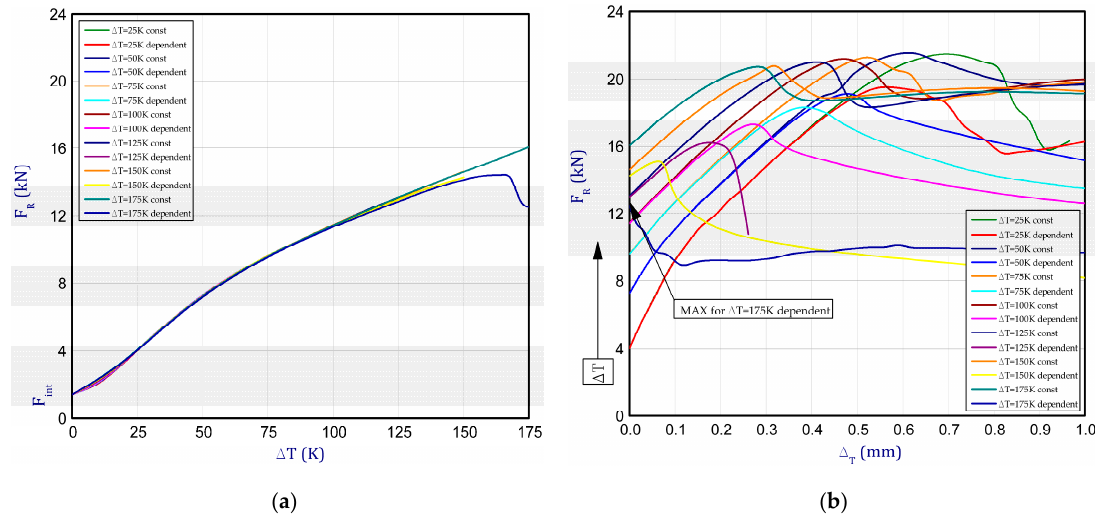
Figure 9. The force reaction vs. ( a ) the temperature increment (BC-2) and ( b ) vs. shortening of column (BC-3) based on finite element method (FEM).